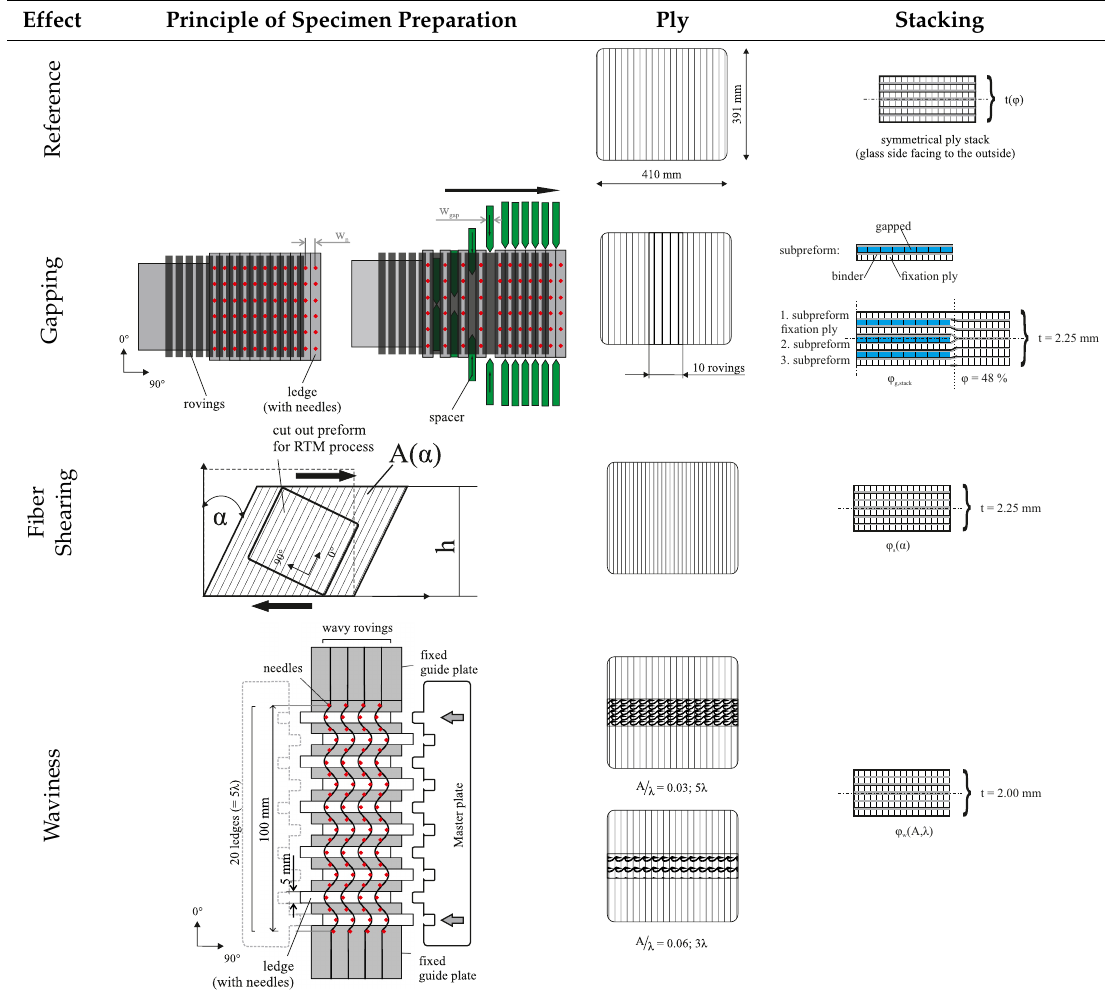
Table 4. Tooling and ply arrangements of implemented draping effects